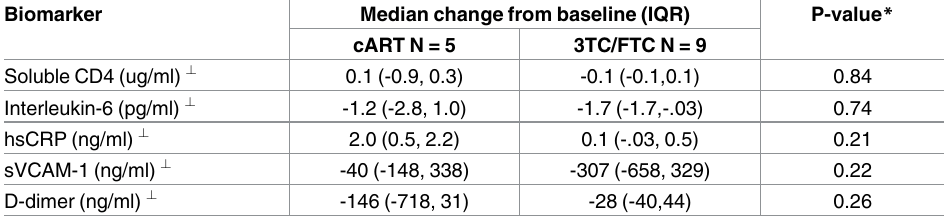
Table 3. Immune activation and inflammation biomarker change from baseline to week